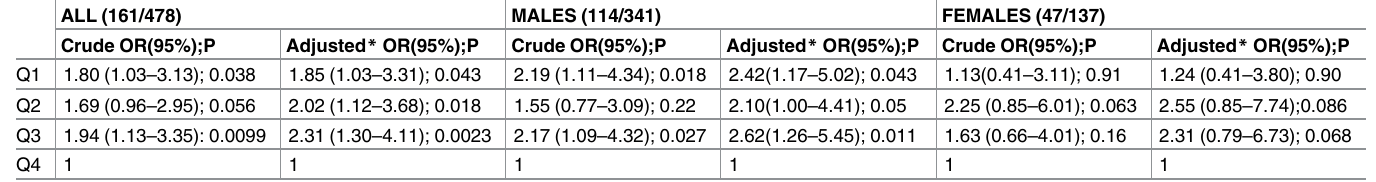
Table 4. Risk of angina/MI in relation to the highest quartile of IgM anti-OxPS. Associationbetweenlevels of IgM anti-OxPS and risk for CVD, (as com- pared to 622 controls) among all participants and men and women separately. In tables, the highestquartile, Q4, is set as 1. Both cases and controls were includedangina/MI as the basis for division into